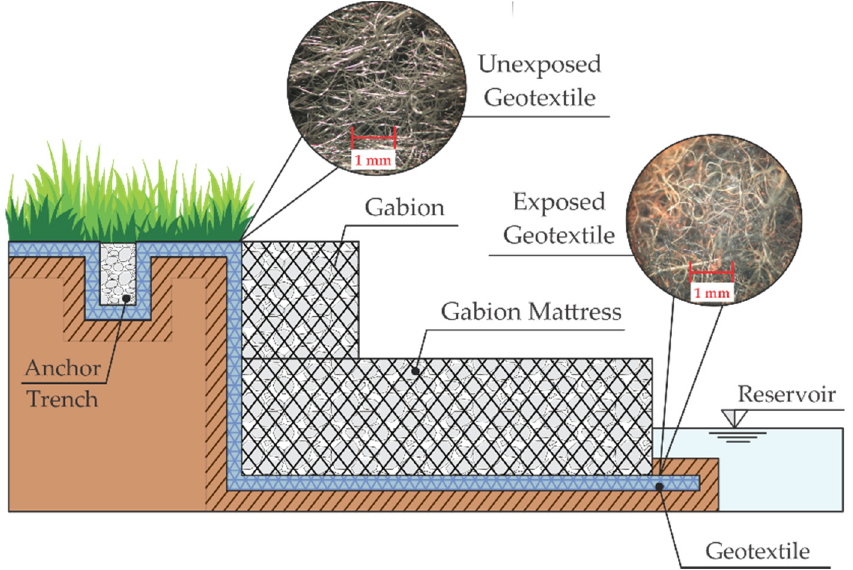
Figure 4. Schematic configuration profile of erosion control techniques, gabion and gabion mattress or geogrid mattress.